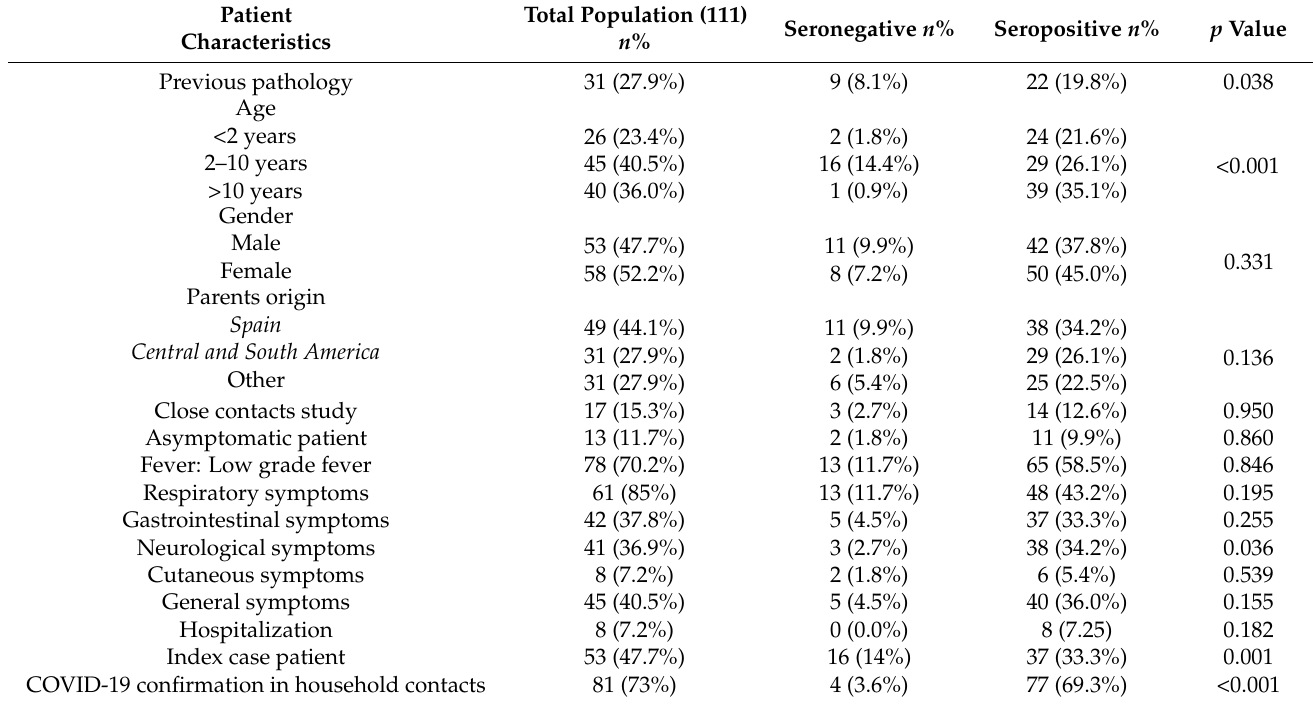
Table 1. Factors associated with seronegativity and